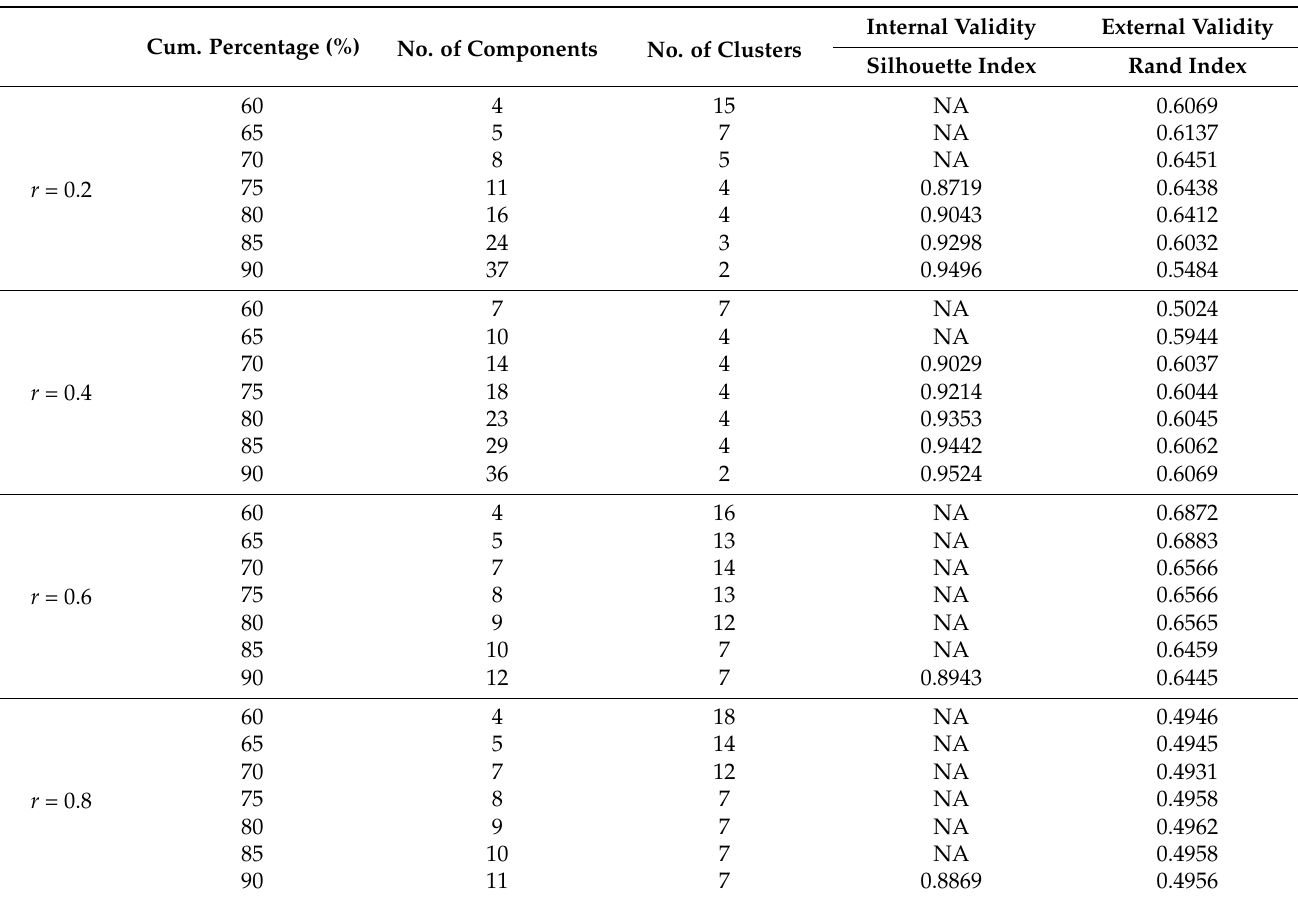
Table 3. Number of components, clusters, and validations for the chosen breakdown